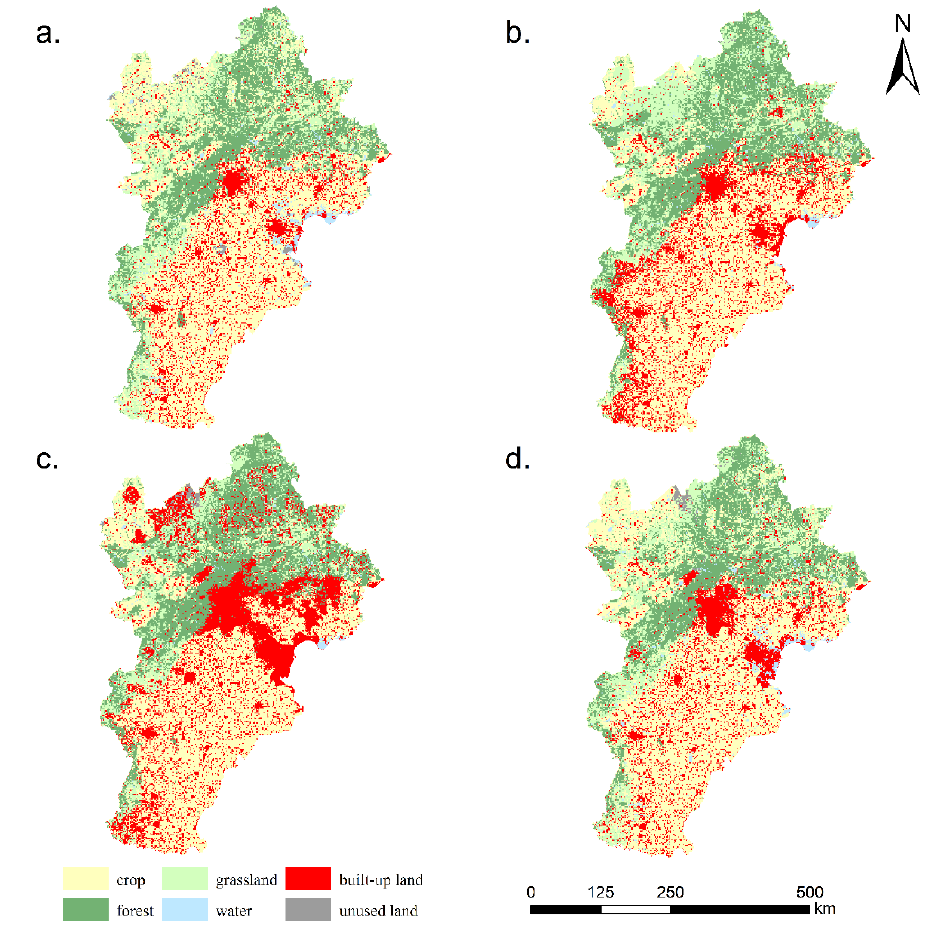
Figure 2. Land-use scenario simulation results. ( a ) 2015; ( b ) conservation scenario; ( c ) development scenario; ( d ) natural scenario.